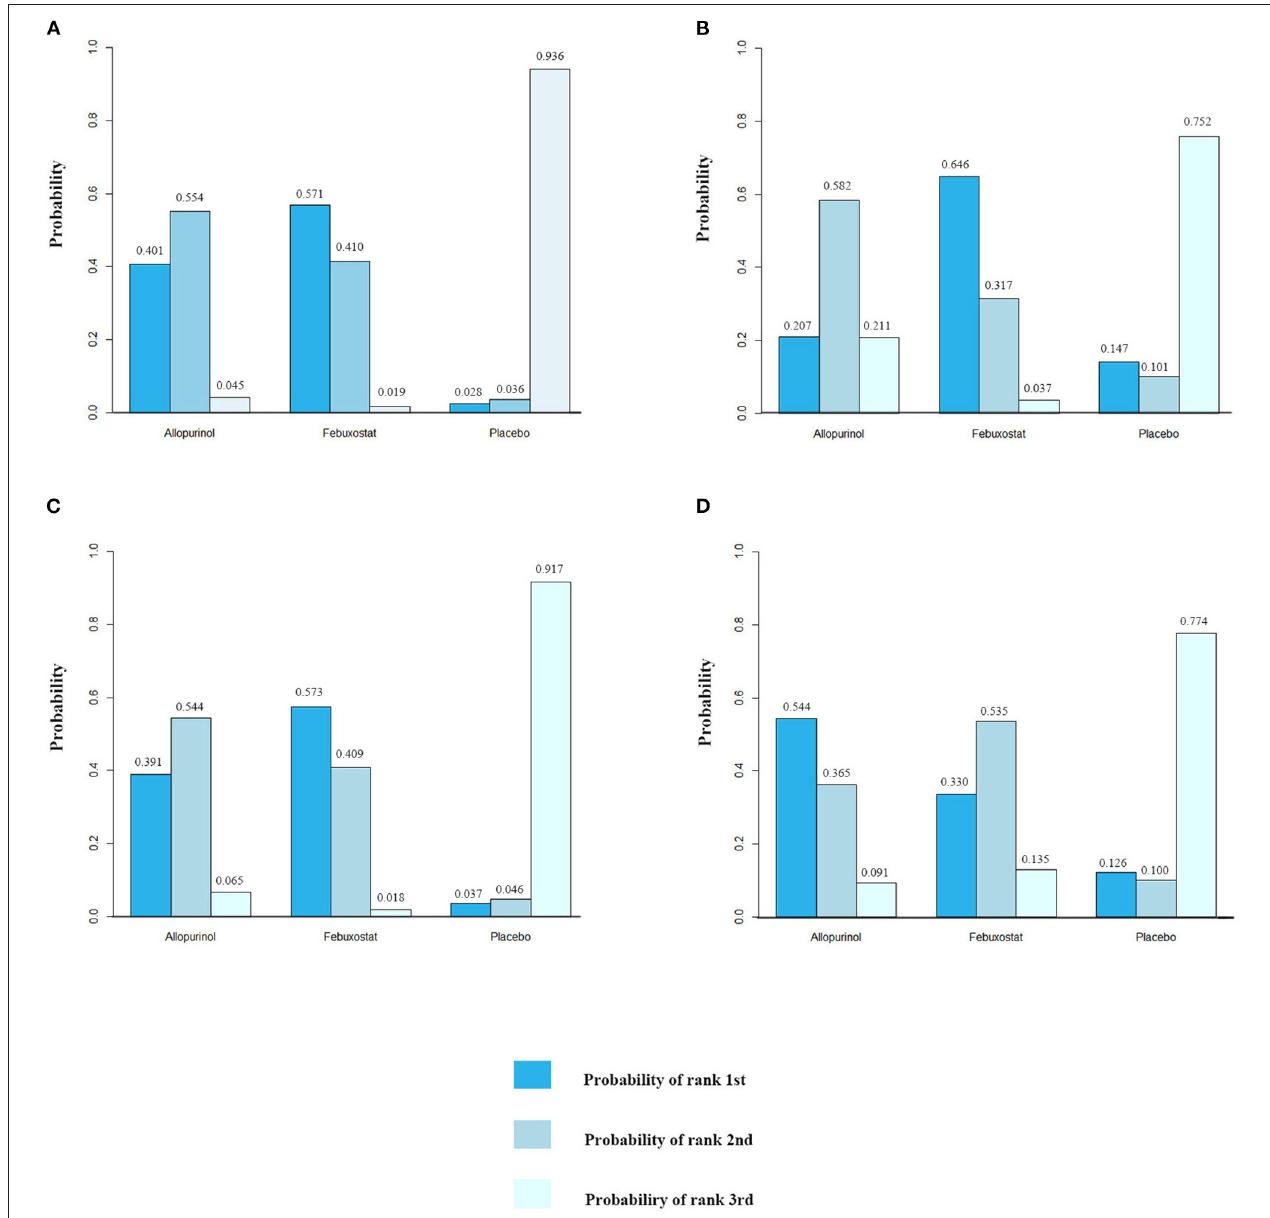
FIGURE 4 | Rank diagram of febuxostat, allopurinol, and placebo for different outcomes. The numbers on the vertical axis represent the probability. (A) MACE (major adverse cardiovascular events), (B) non-fatal MI (myocardial infarction), (C) non-fatal stroke, and (D) cardiovascular death.